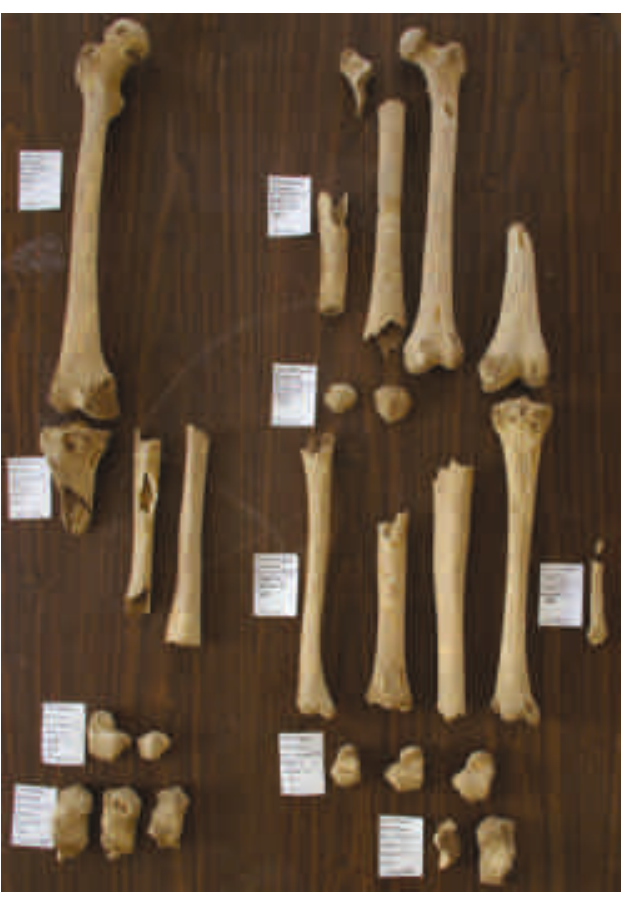
Figure 4 Lower limb bones from Grave 20, Katsalos cemetery representing at least three